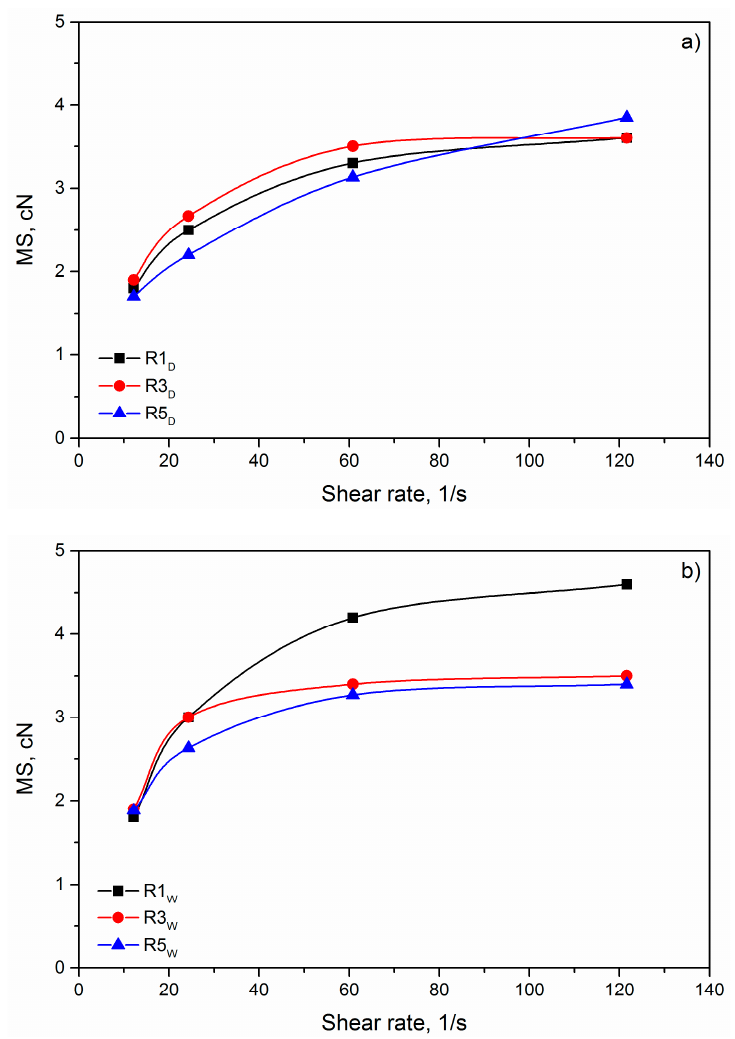
Figure 2. Melt strength (MS) as a function of the apparent shear rate for ( a ) dried sample and ( b ) wet sample.